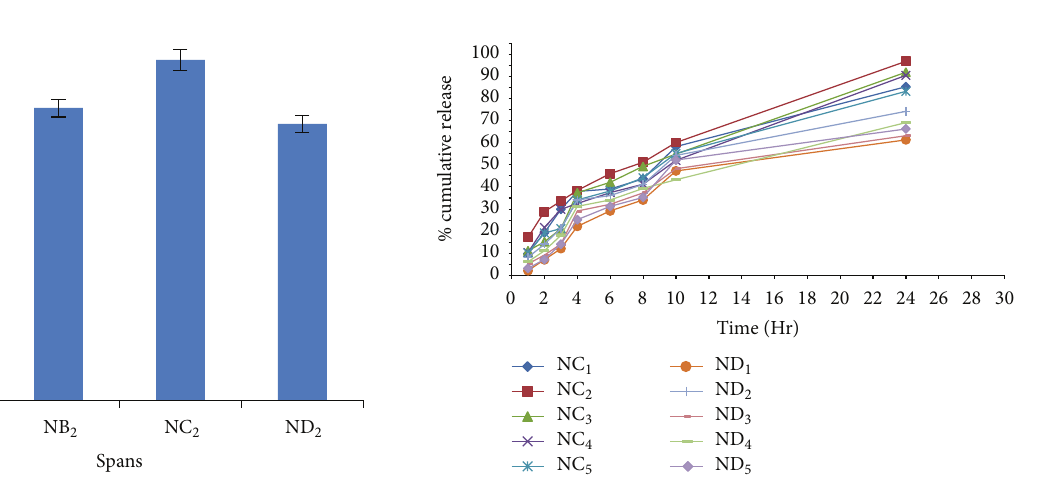
Figure 6: Comparative release profile of selected niosomal formu-